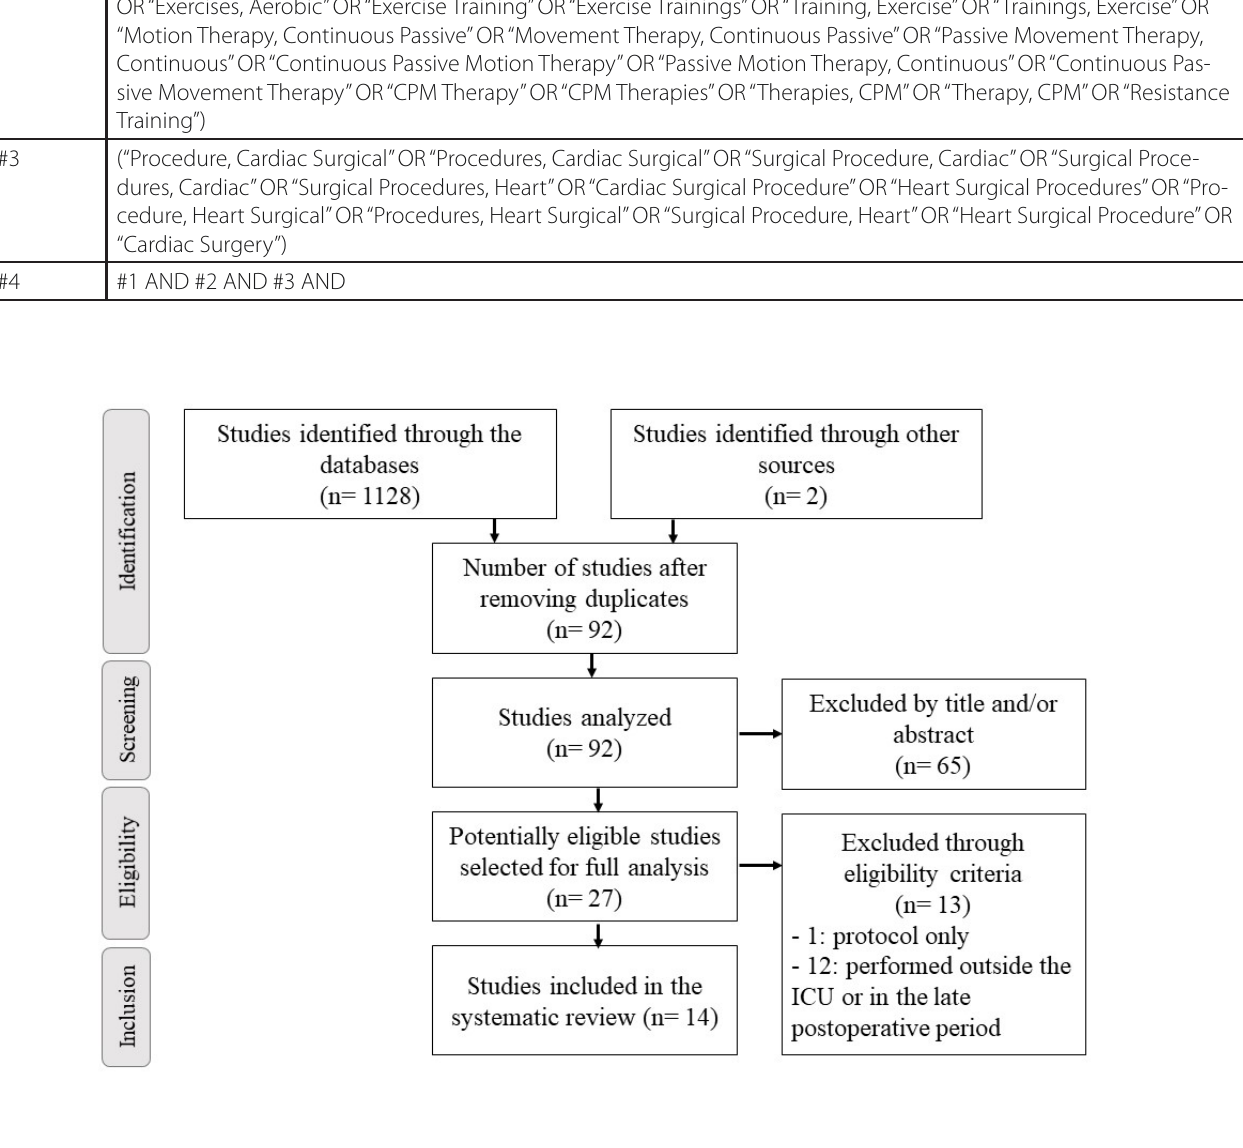
Fig. 1 - Flowchart of studies included in this systematic review. ICU=intensive care